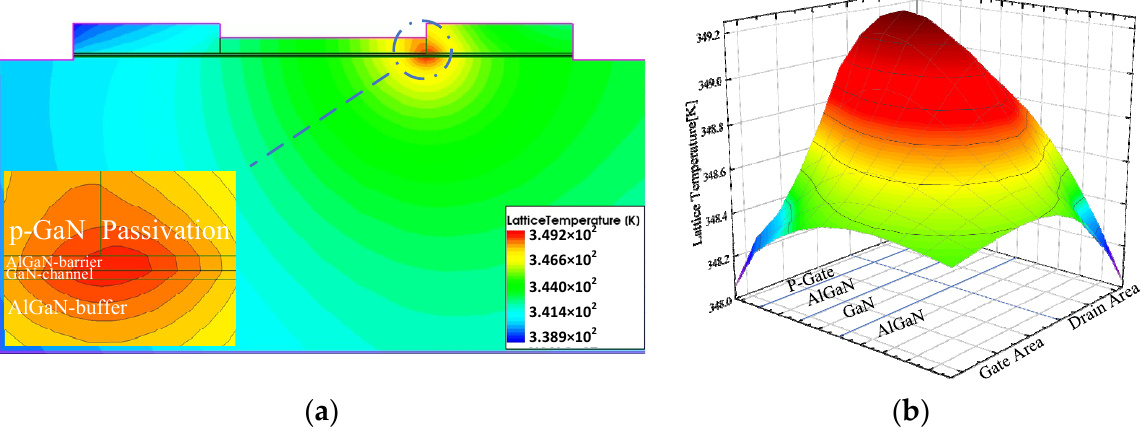
Figure 7. ( a ) Internal thermal distribution of the device under self-heating effect; ( b ) thermal distri- bution near the hot spot.